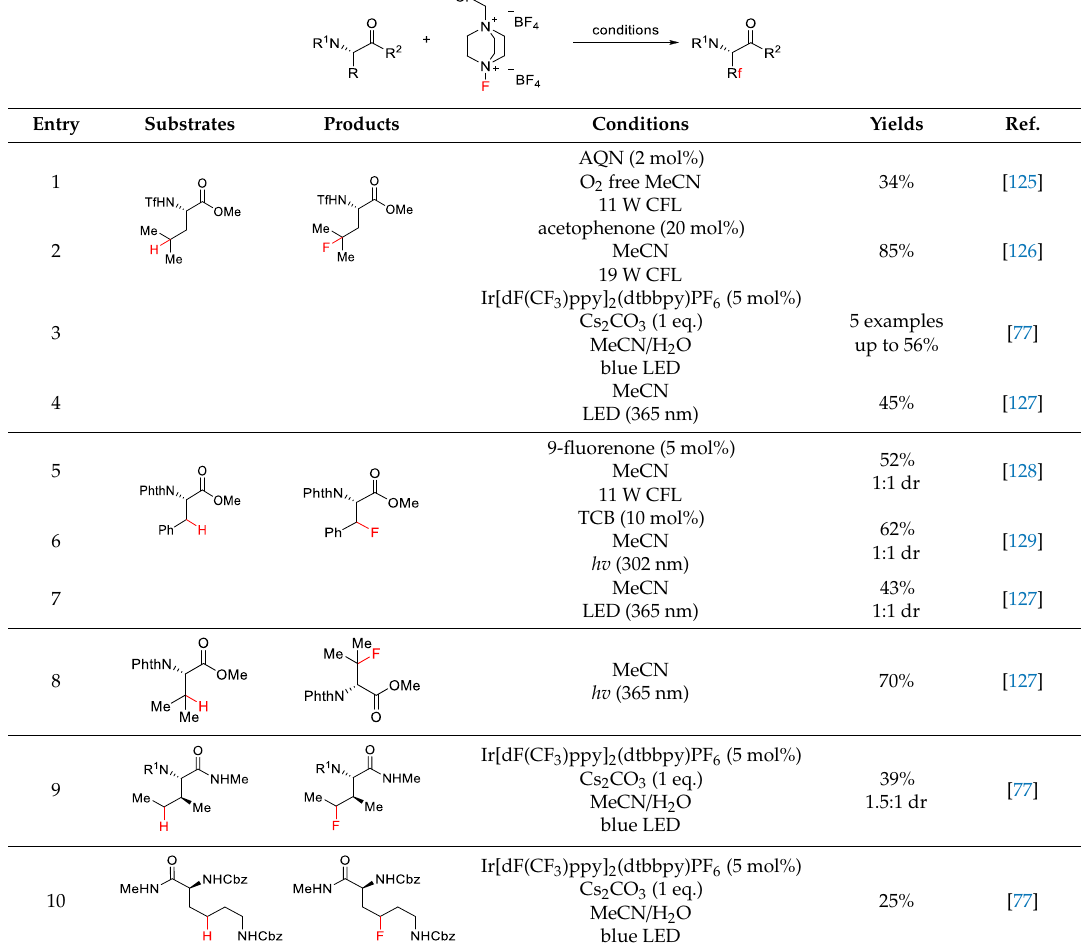
Table 1. C(sp 3 )–H fluorination of amino acids with Selectfluor.